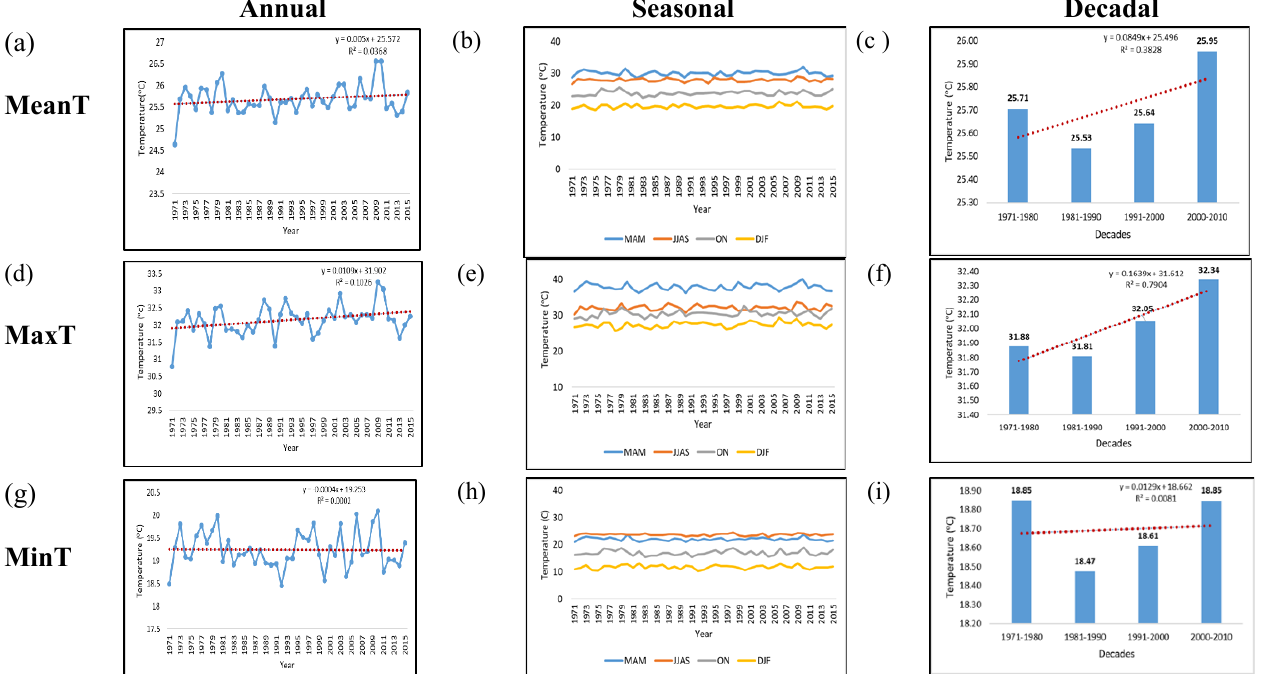
Fig 4. Mean, seasonal and decadal temperature trends from 1971-2015 for MeanT (a-c), MaxT (d-f) and MinT (g-i) respectively Similarly, in case of MaxT, 0.16°C per annum and 0.79 °C